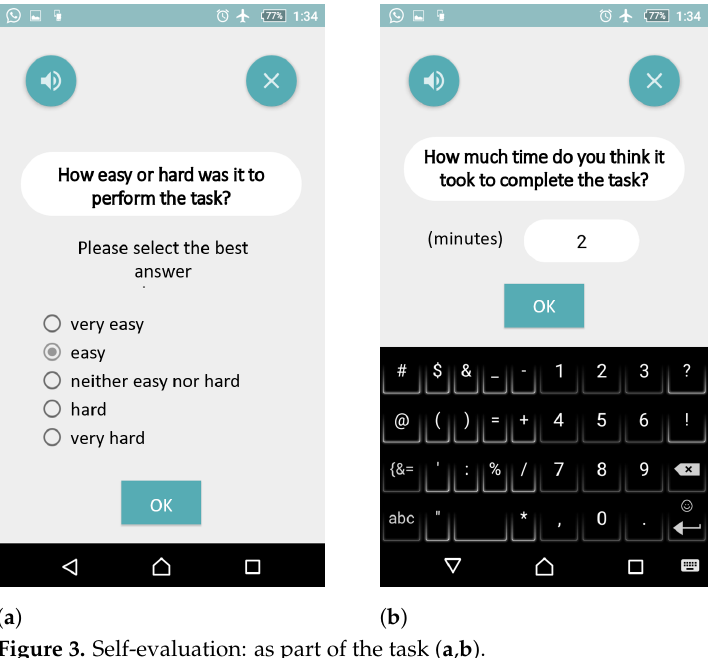
Figure 3. Self-evaluation: as part of the task ( a , b